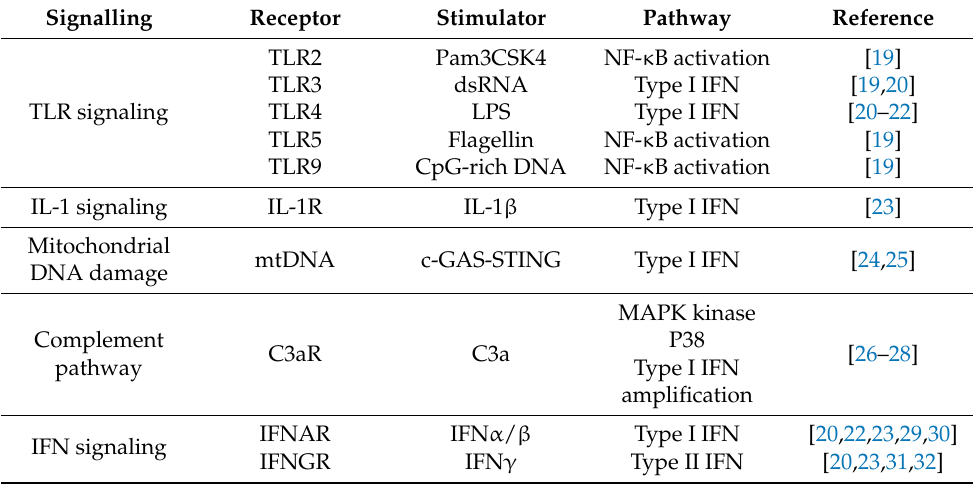
Table 1. Stimulators of caspase ‐ 11 expression.